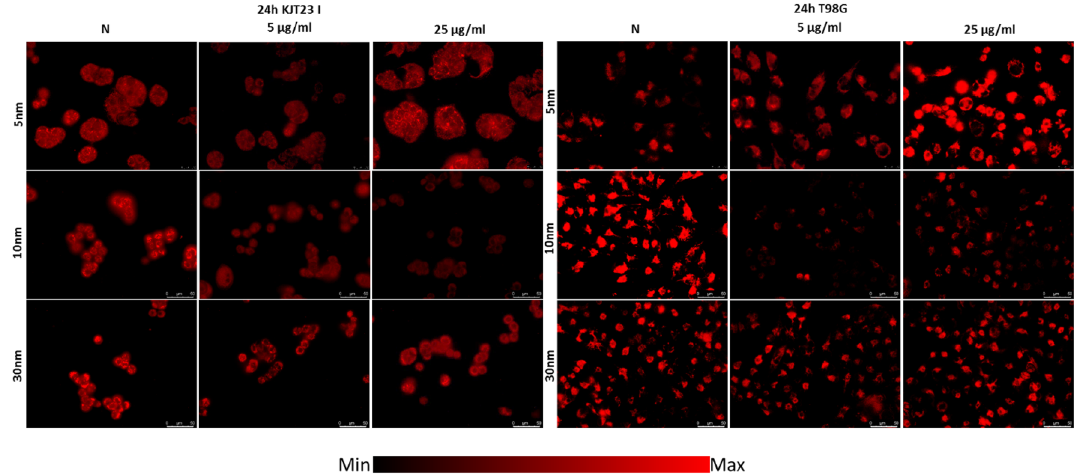
Figure 9. Microscopic images of KJT23I and T98G cells presenting ROS levels after 24 h of exposure to IONPs with 5 nm, 10 nm and 30 nm diameters in concentrations of 5 µg Fe/ml and 25 µg Fe/ml compared with control group (N).